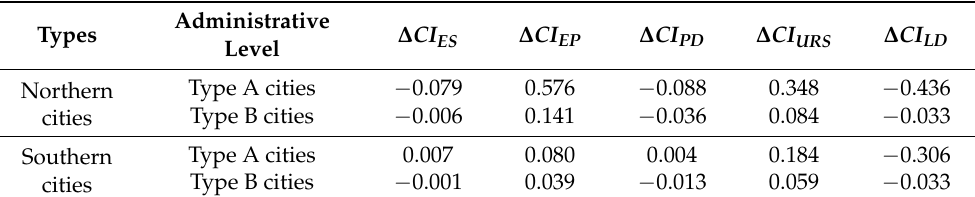
Table 5. Decomposition results for the northern and southern cities during 2010–2015 (tCO 2 / (10 4